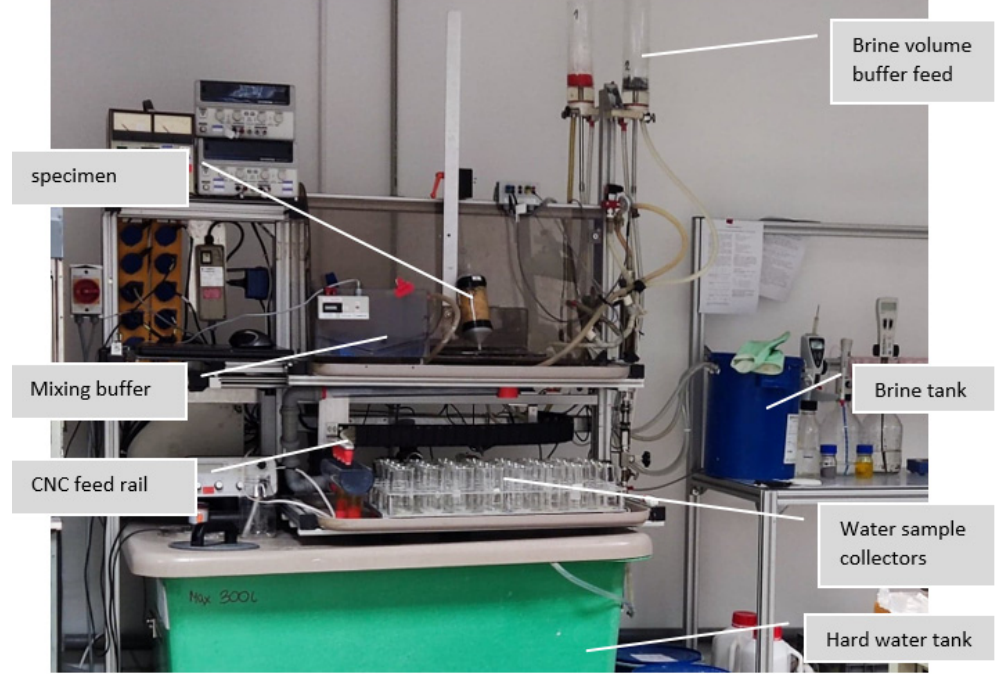
Figure 4. Picture of the described Sanhua Aweco proprietary resin testing equipment.